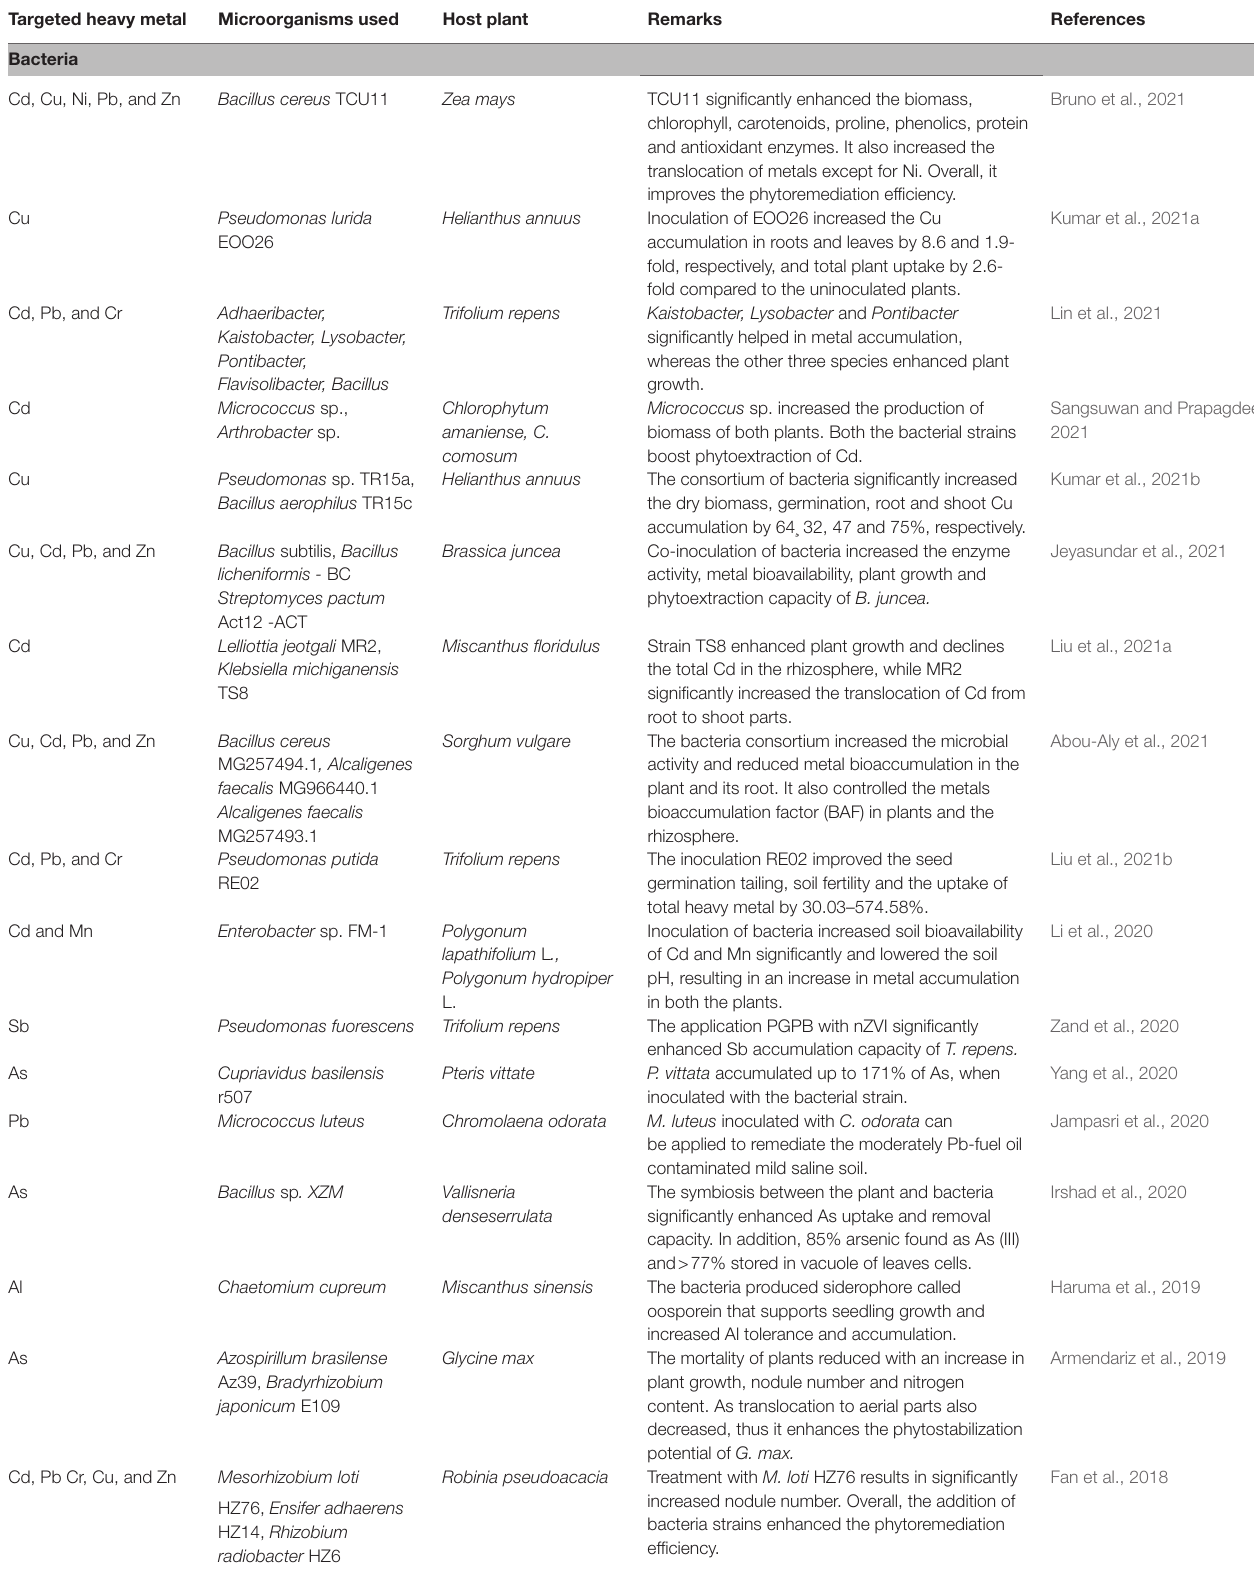
TABLE 5 | Role of microorganisms in the removal of heavy metals by plants. Targeted heavy